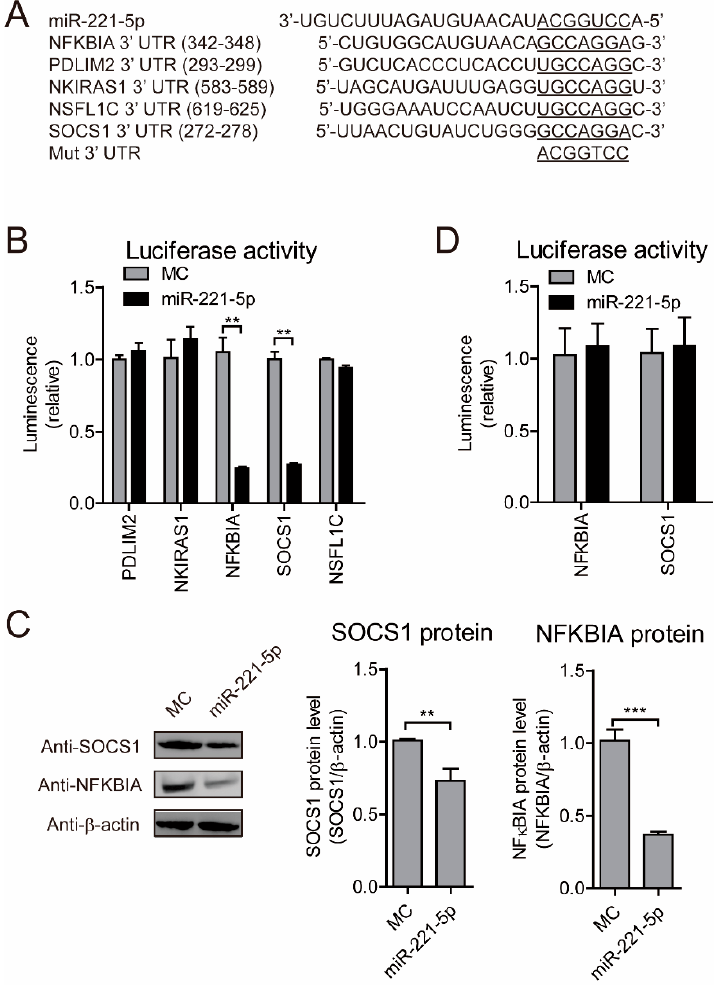
Figure 7. NFKBIA and SOCS1 are miR-221-5p targets. ( A ) Schematic representation of base pairing between miR-221-5p and the 3 ′ UTRs of Macaca mulatta NFKBIA (also known as I κ B α ), PDLIM2 , NKIRAS1 , NSFL1C , and SOCS1 . ( B ) Luciferase activity in 293T cells co-transfected with miR-221-5p and plasmids containing the 3 ′ UTRs of NFKBIA , PDLIM2 , NKIRAS1 , NSFL1C , and SOCS1 , respectively, for 48 h. Data were normalized against firefly luciferase activity. ( C ) Immunoblot analysis of NFKBIA and SOCS1 levels in MARC-145 cells transfected with 50 nM miR-221-5p mimics or MC for 24 h, and infected PEDV CH/HBTS/2017 at an MOI of 0.1 for 24 h. Intensity representing NFKBIA and SOCS1 levels (right) normalized against that for β -actin across three independent experiments. ( D ) Luciferase activity in 293T cells co-transfected with miR-221-5p and plasmids containing NFKBIA and SOCS1 3 ′ UTRs. Comparisons between groups were determined by Student’s t test. ** p < 0.01. *** p < 0.001.